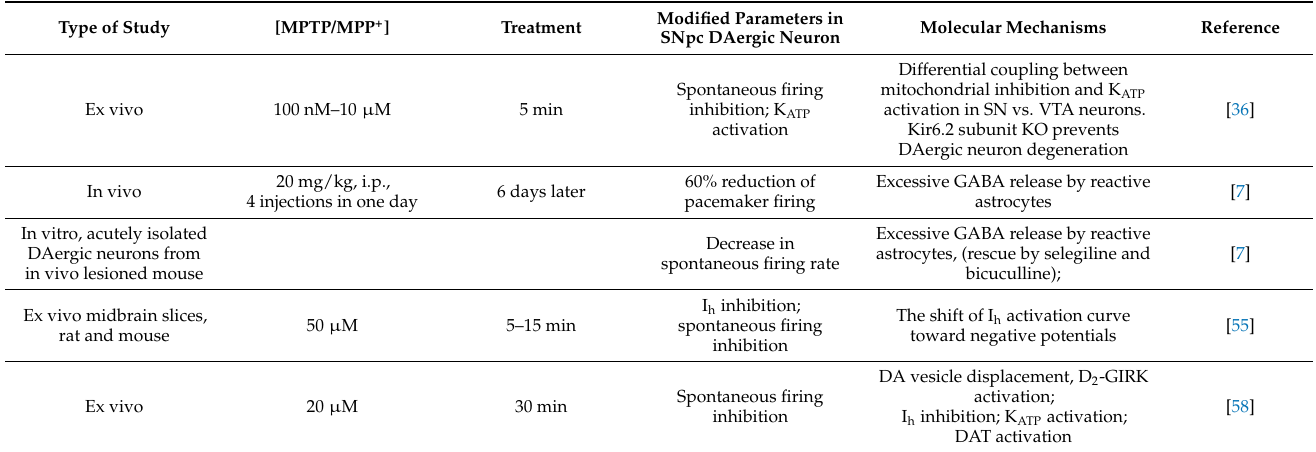
Table 3. Summary of the principal findings reported by the cited literature on MPP + /MPTP effects on SNpc DAergic neuron functional